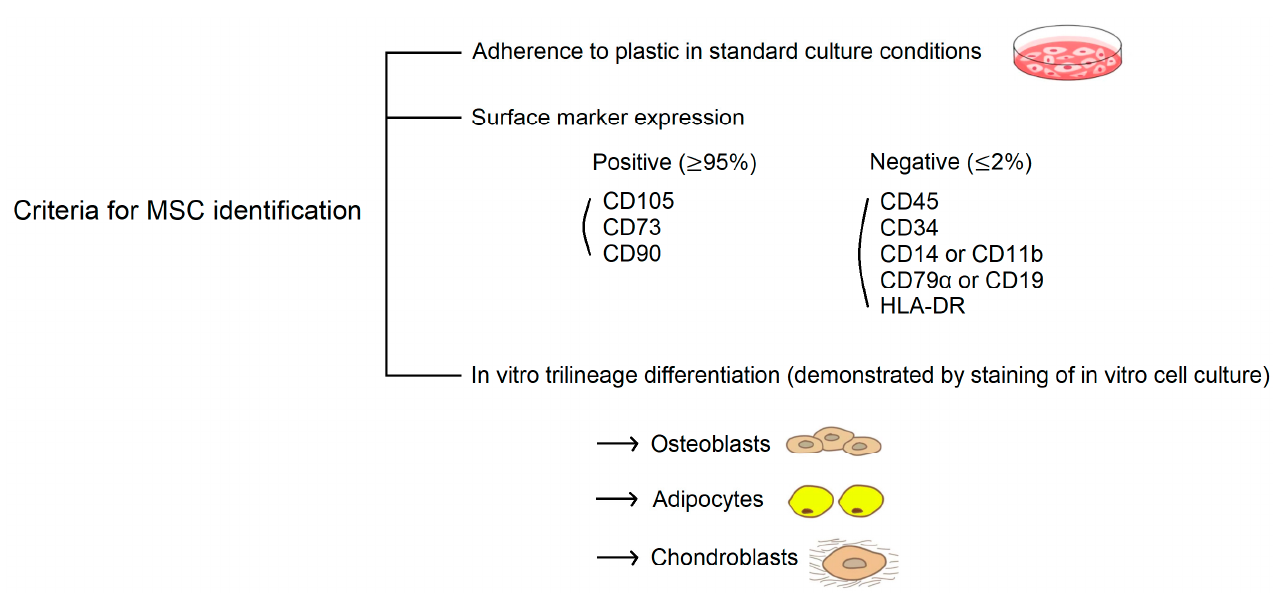
Figure 2. Criteria of the International Society for Cellular Therapy (ISCT) for the definition of human MSCs.